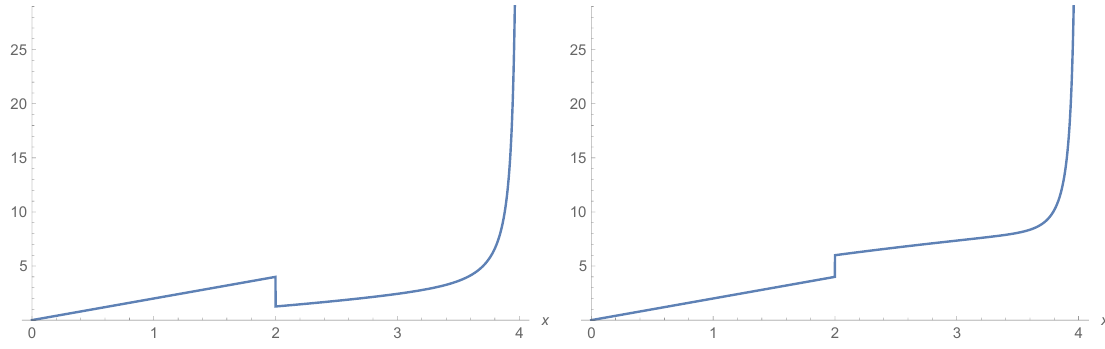
Figure 1. The system hazard rate (5) is shown for the cases of Example 1 for ( λ , k ) = ( 1,2 ) , and ( µ , h ) = ( 2,2.5 ) on the left, and ( µ , h ) = ( 0.5,1.5 ) on the right, with u = 2 and t =